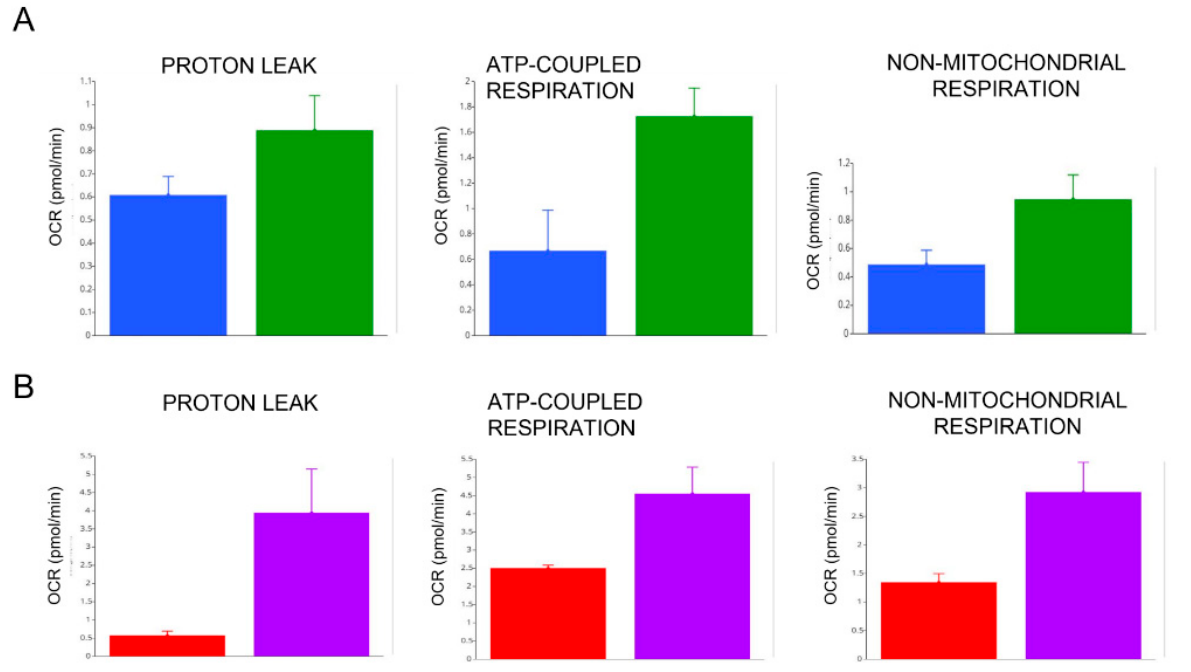
Figure 6. Mitochondrial respiration in two COVID-19 patients in the pilot study. Seahorse analysis of proton leak, ATP-produced respiration and non-mitochondrial respiration, performed on PBMCs obtained from COVID-19 patients with NTIS and treated in vivo and in vitro with LT3. ( A ) Analysis of the PBMCs from patient 1 before (in blue) and after (in green) in vitro treatment with 100 nM of LT3 for 1 h. ( B ) analysis of the PBMCs from patient 2 before (in red) and after (in purple) in vivo treatment with 63.9 µg/die of LT3, given orally for one week.